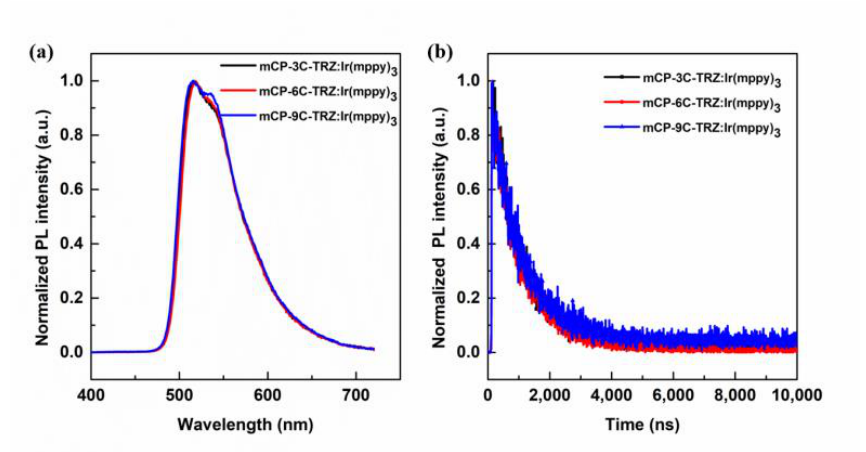
Figure 6. ( a ) The PL spectra and ( b ) transient PL decay spectra of Ir (mppy) 3 doped into mCP-3C-TRZ, mCP-6C-TRZ and mCP-9C-TRZ films (5 wt%) at room temperature.